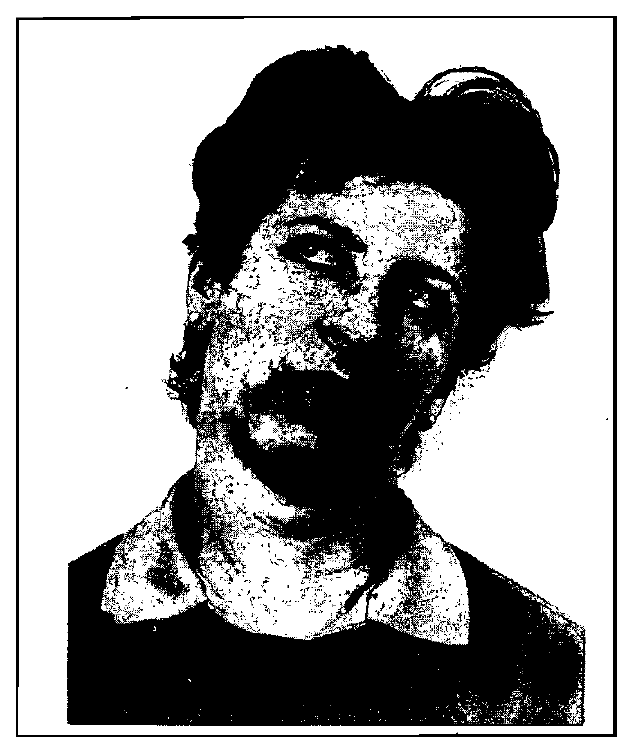
Figure 6c: Examples of nonmanual Behaviour. ments and negatives. Nonmanual behaviour is also used in an adverbial way to illustrate concepts such as ease, effort, enjoyment, intensity, etc. (See Figure 6.)